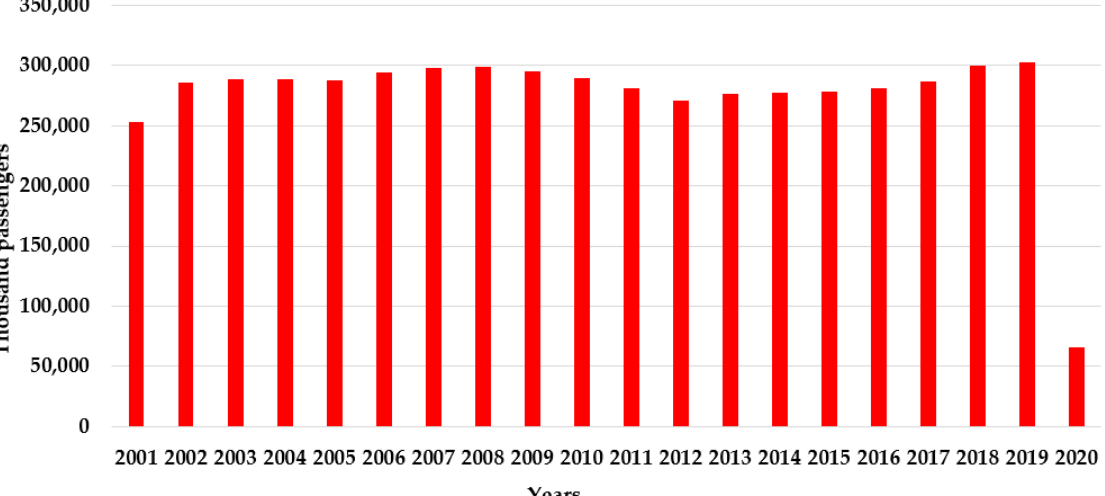
Figure 7. Total passengers transported to/from main ports of European countries for the period 2001 – 2020.